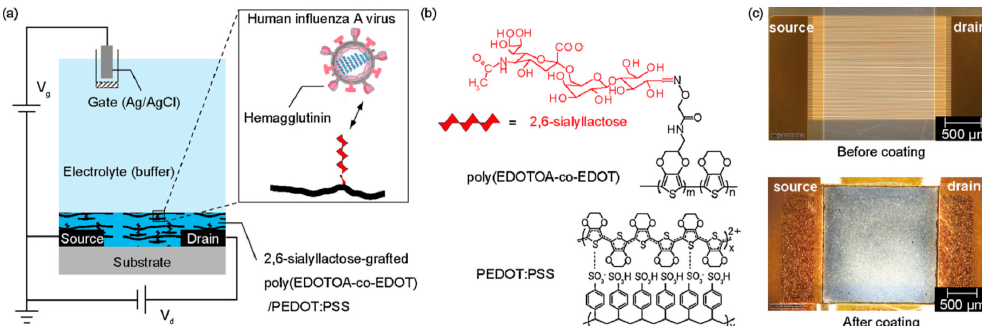
Figure 16. An organic electrochemical transistor device for specific human influenza A virus sensing. ( a ) Schematic cross section of the organic electrochemical transistor device with a thin layer of 2,6-sialyllactose-grafted polymer in an electrolyte; ( b ) chemical structures of 2,6-sialyllactose-grafted polymer; ( c ) optical micrographs showing top view of the interdigitating drain–source microelectrodes before and after the coating of a polymer thin film. Scale bar: 500 um. Reproduced with permission from [130]. Copyright Elsevier, 2018.